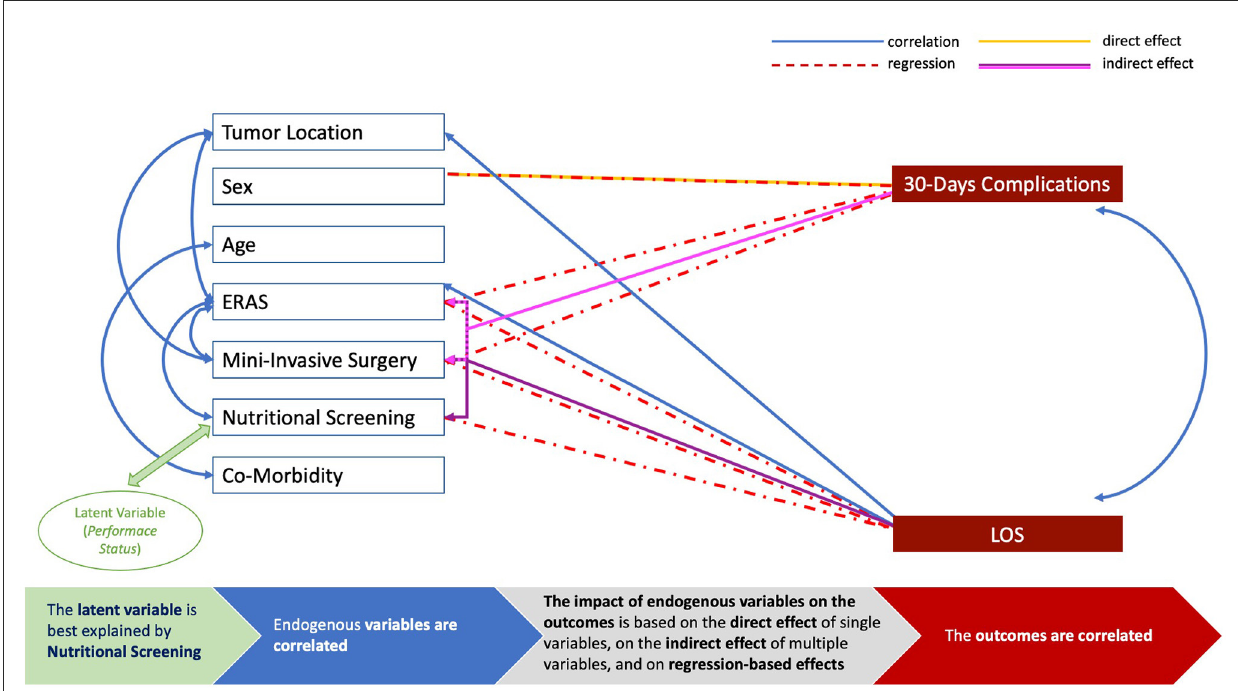
FIGURE4 Graphical representation of the structural equation modeling (SEM) analysis. The blue boxes represent endogenous variables and the blue arrows are depicted to link inter-variables correlations of statistical value ( p < 0 · 05, see Table 4); the red boxes are for the outcomes of interest (LOS, length of postoperative hospital stay; 30-day complications, 30-day postoperative complications); the green box is for the latent variable to represent patients’ performance status, and the green arrow is to link this latent factor with the endogenous variable of statistical value ( p < 0 · 05, see Table 4); the red arrows show regression-based effects with statistical significance ( p < 0 · 05, see Table 4); the yellow arrows show direct effects of statistical value ( p < 0 · 05, see Table 4); the purple arrows show the indirect effect with statistical significance ( p < 0 · 05, see Table 4). The bottom line provides an explanation of the SEM